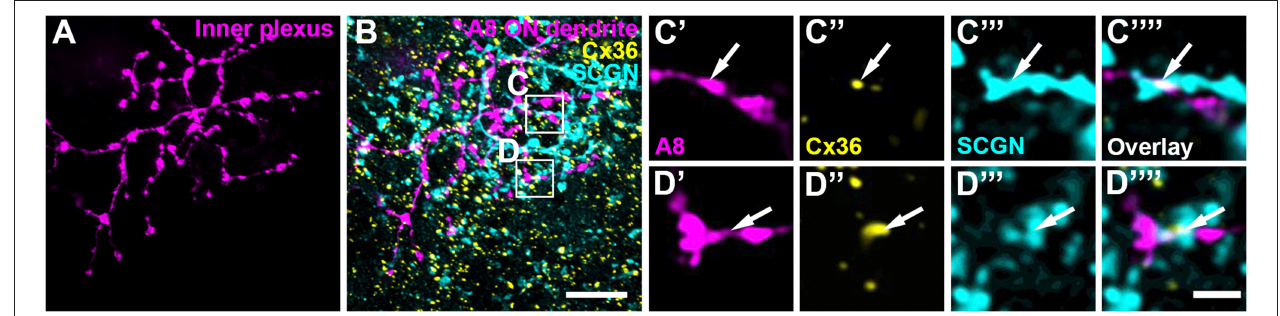
FIGURE 4 | Cx36 puncta on A8 ON dendrites colocalized with secretagogin (SCGN). (A) Maximum projection of A8 ON dendrites. (B) Maximum projection of the overlay of Cx36 and SCGN with the ON dendrites of an injected A8 cell. (C,D) Selected ROI from B. (C’–D””) Magnified images of A8 dendrites (C’,D’) , Cx36 (C”,D”) , SCGN (C”’,D”’) and their respective overlay (C””,D””) within a single section from the selected ROI. Arrows denote colocalization of all three channels. Scale bar: (A,B) , 10 µ m; (C’–D””) , 2 µ m.